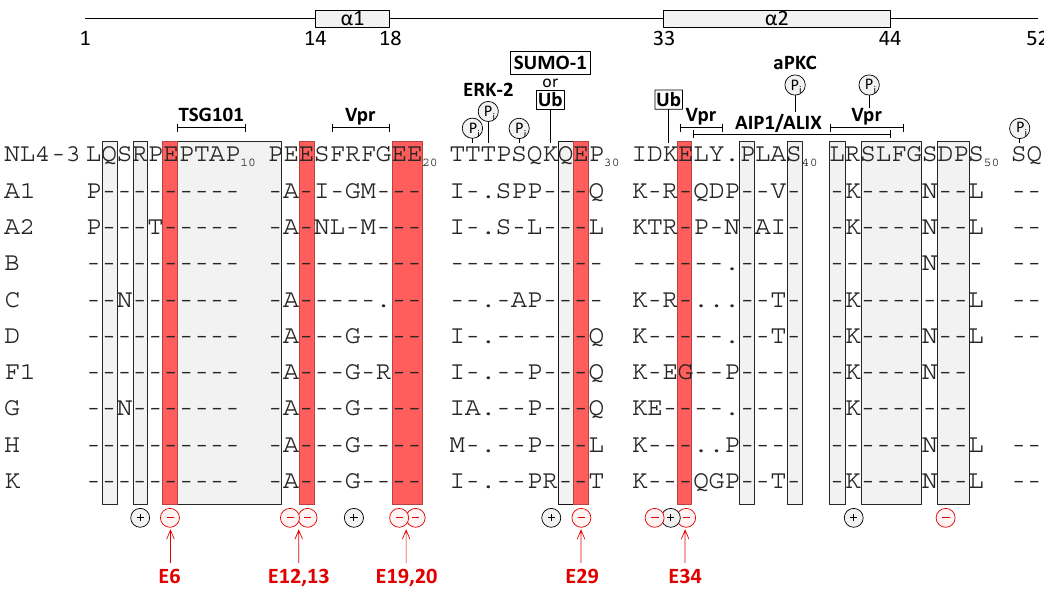
Figure 1. Amino acid sequence of p6 derived from the isolate HIV-1 NL4-3 with previously identified structural and functional domains [50], charge distribution and sites of posttranslational modifications. Delineated in red are conserved Glu residues at positions 6, 13, 19, 20, 29, and 34. Positively and negatively charged residues, previously identified phosphorylation sites for ERK-2 and aPKC [35,36], attachment sites for ubiquitin [21] and SUMO-1 [22], binding domains for Tsg101 [8–10,34,51], ALIX [12], and Vpr [49] and structural domains identified by NMR [50] are indicated. Consensus sequences of p6 proteins derived from the M-group viruses [52] were aligned and conserved amino acids are boxed in grey.